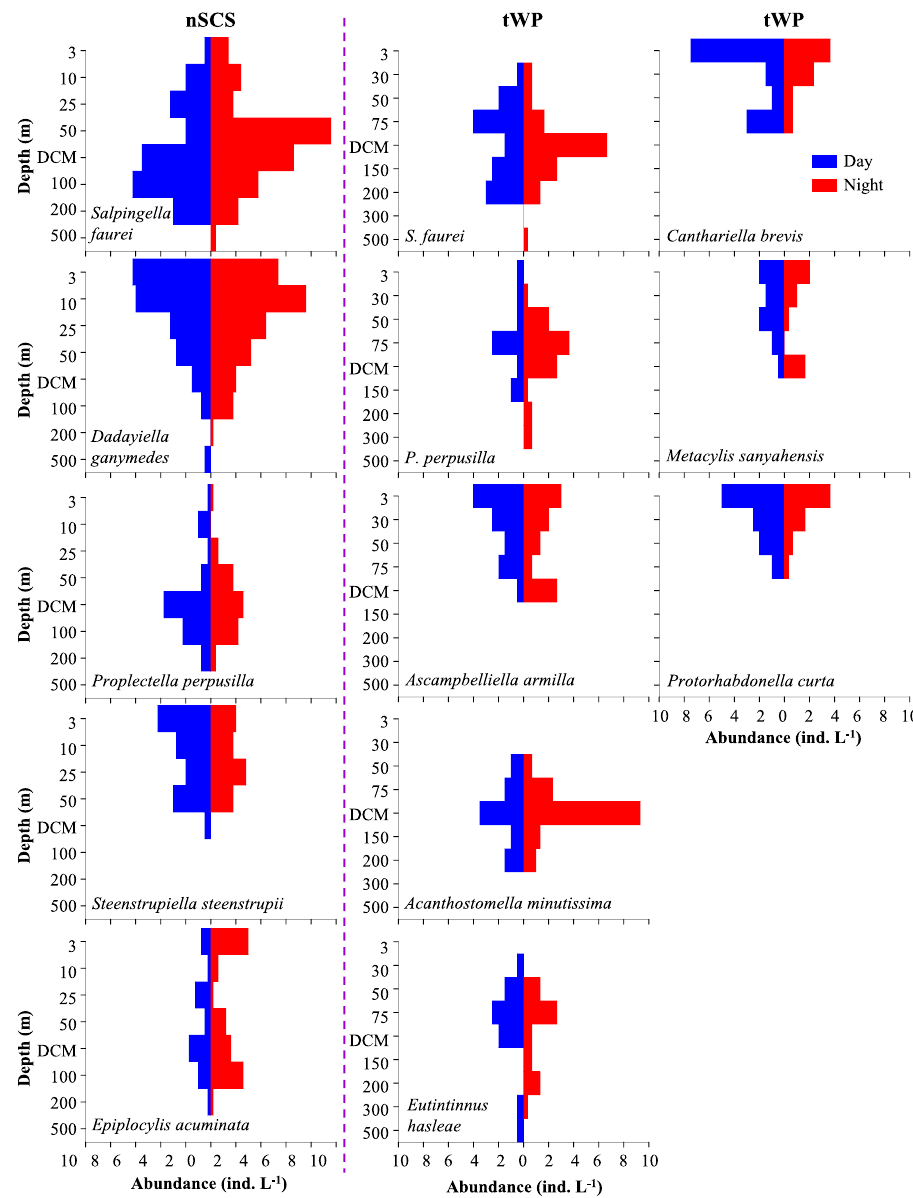
Figure 4. Diel variations of average abundance of tintinnid dominant species at each layer in the nSCS and